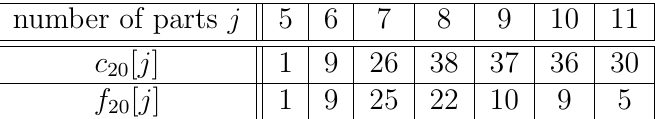
[ j ]) and forcibly (row f 20